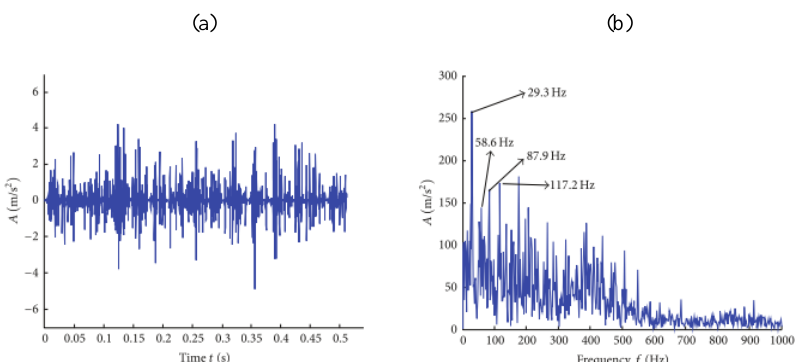
Figure 12. Low-resonance component of gearbox fault vibration signal. ( a ) Time-domain waveforms; ( b ) Demodulation spectrum [38].